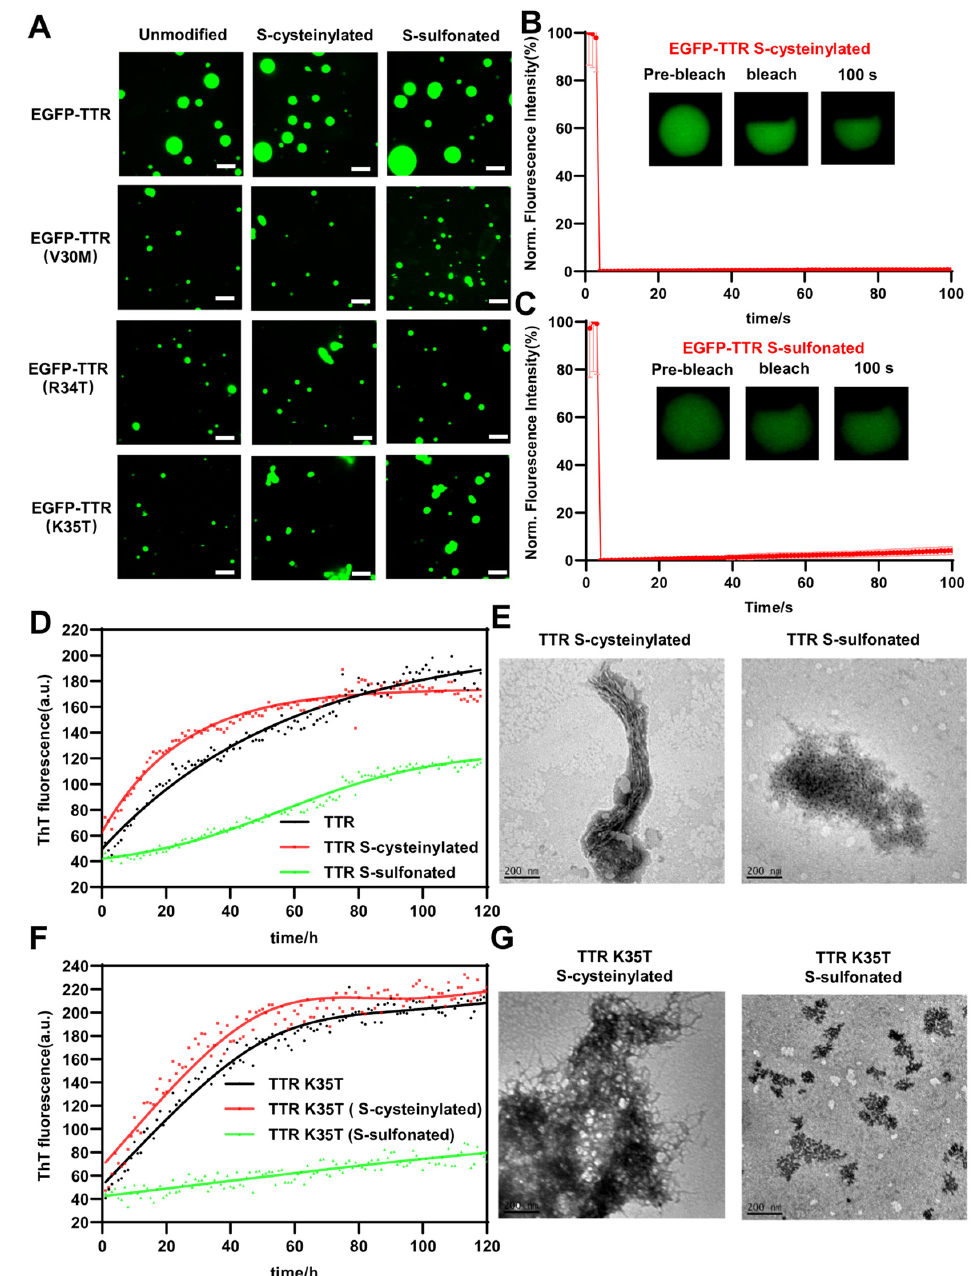
Figure 4. The effects of S-cysteinylation and S-sulfonation on TTR droplets and aggregation. ( A ) Con- focal microscope images of 10 µ M unmodified, S-cysteinylated and S-sulfonated EGFP-TTRs and disease-related mutants at pH 4.4. Scale bar, 2.5 µ m. ( B ) FRAP of 10 µ M S-cysteinylated EGFP-TTR at pH 4.4. Error bars represented SEM (n = 3). ( C ) FRAP of 10 µ M S-sulfonated EGFP-TTR at pH 4.4. Error bars represented SEM (n = 3). ( D ) The ThT fluorescence intensity traced for 40 µ M unmodified, S-cysteinylated and S-sulfonated TTR at pH 4.4, 37 ◦ C. ( E ) TEM image of fibrillar aggregates formed from 40 µ M unmodified, S-cysteinylated and S-sulfonated TTR for 30 days at pH 4.4, 37 ◦ C. Scale bar, 200 nm. ( F ) The ThT fluorescence intensity traced for 40 µ M unmodified, S-cysteinylated and S-sulfonated TTR (K35T) at pH 4.4, 37 ◦ C. ( G ) TEM image of fibrillar aggregates formed from 40 µ M unmodified, S-cysteinylated and S-sulfonated TTR (K35T) for 30 days at pH 4.4, 37 ◦ C. Scale bar, 200